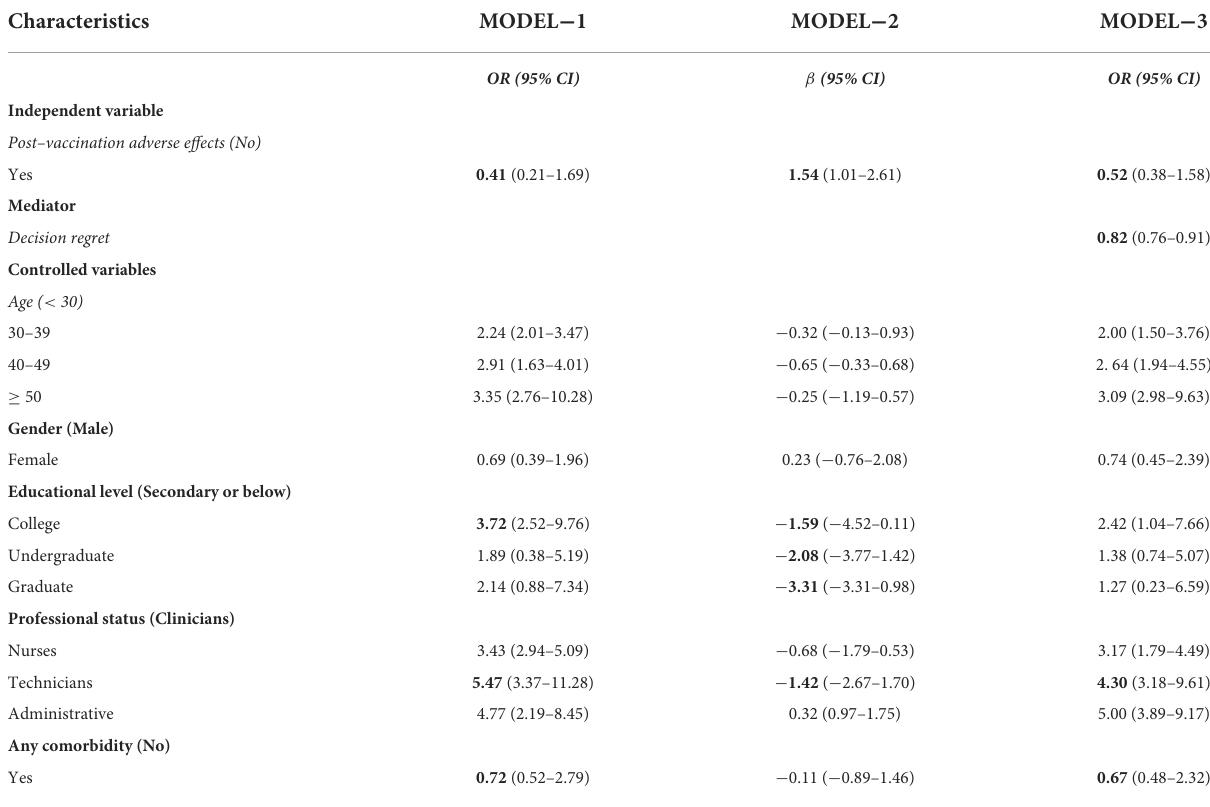
TABLE 5 Evaluating decision regret as a mediating